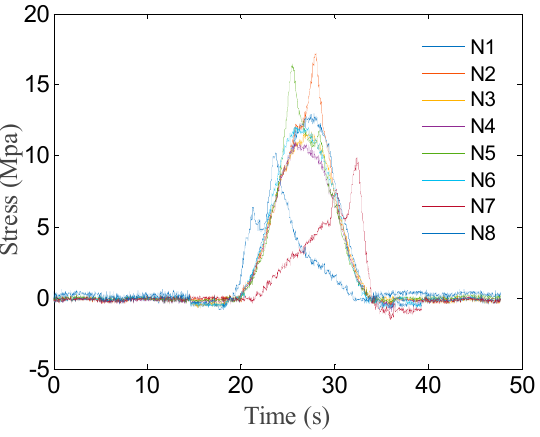
Figure 16. Stress response of measurement points N1~N8 for TP x = − 1.5 cm.